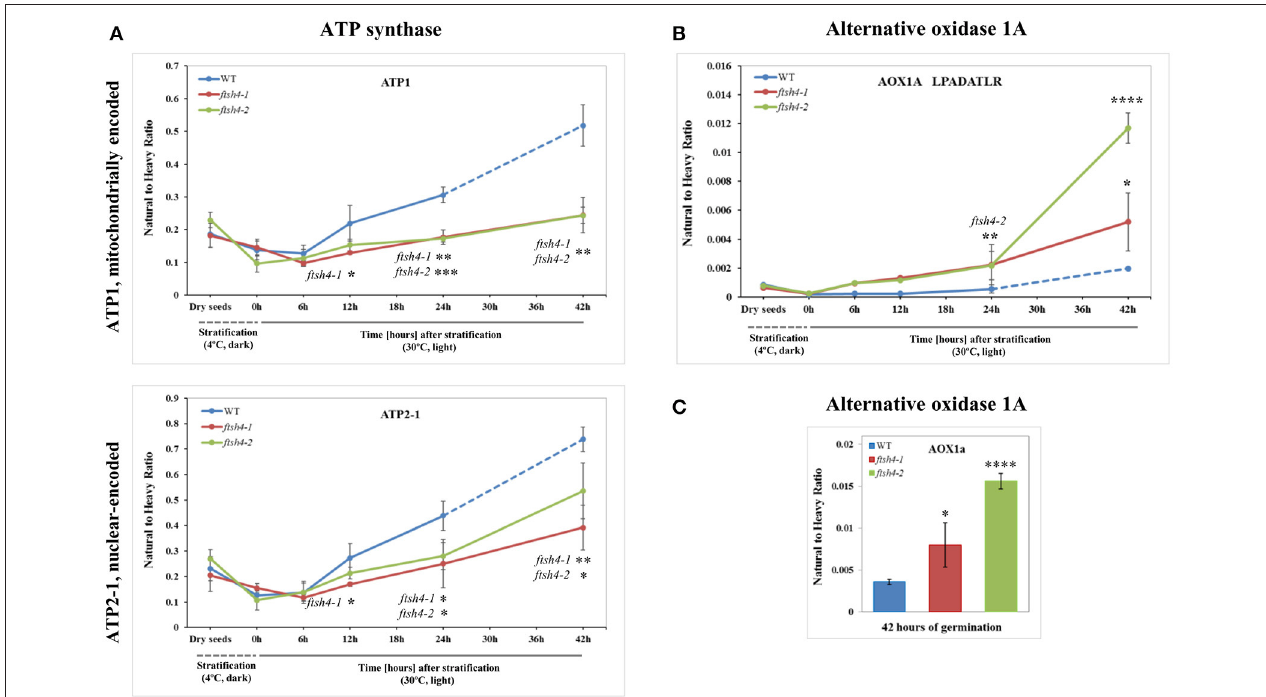
FIGURE 6 | Quantitative time-course profiling of selected ATP synthase subunits (A) and alternative oxidase 1A (AOX1A) in ftsh4 mutant seeds in comparison to those of WT during germination estimated by MRM. (A) Data show the abundance of ATP1 (AtMg01190) determined as the geometric mean of the peptides GIRPAINVGLSVSR, EAFPGDVFYLHSR, AVDSLVPIGR and TTIAIDTILNQK as well as ATP2-1 (At5g08670) and the peptides FTQANSEVSALLGR, DAPALVDLATGQEILATGIK and VGLTGLTVAEYFR. (B) Data show the abundance of AOX1A (At3g22370) using the peptide LPADATLR. (C) Data show the abundance of AOX1A determined as the geometric mean of the peptides GIASYWGVEPNK and DVNHFASDIHYQGR in seeds after 42h of germination. Data are mean ± SD of three independent biological replicates, with the exception of AOX1A and peptide LPADATLR (B) , where the results of one replicate for dry seeds, 0, 6, and 12h are shown. * p ≤ 0.05; ** p ≤ 0.01; *** p ≤ 0.001; **** p ≤ 0.0001. Other descriptions are the same as in Figure 4 .